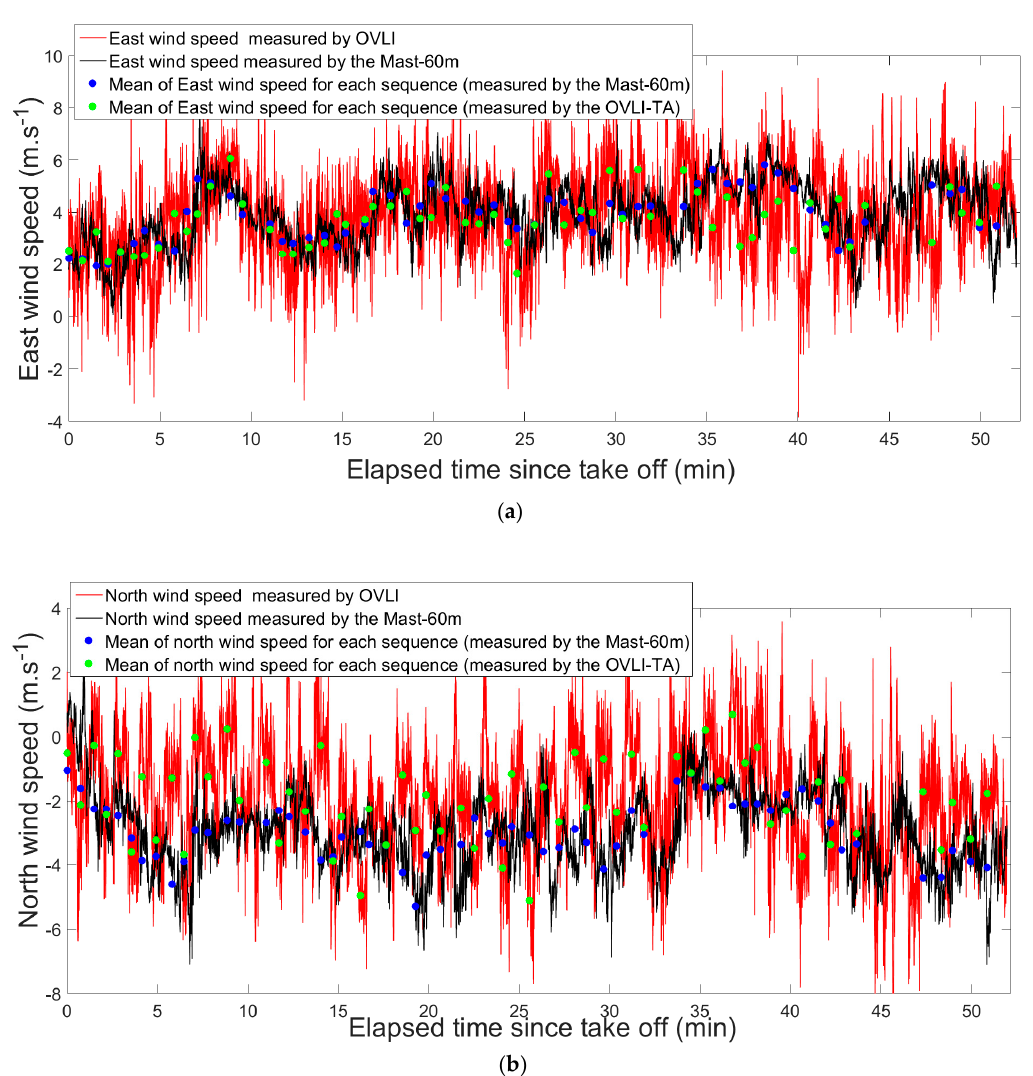
Figure 12. Continuous lines: north and east wind speeds measured by OVLI-TA (in red) and on the tower at 60 m (in black), during the whole flight. Dots: mean of north and east wind speeds for each straight and level sequence of the flight measured by OVLI-TA (in green), and on the tower at 60 m for the same periods of time (in blue).